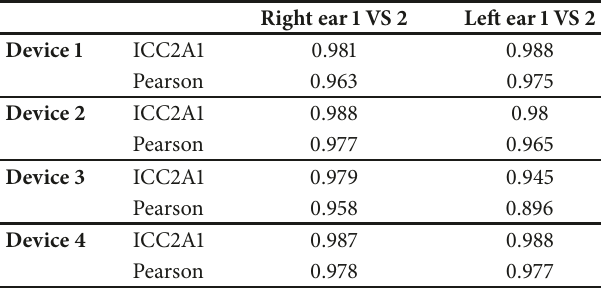
Table 1: Demographic Characteristics n=21.